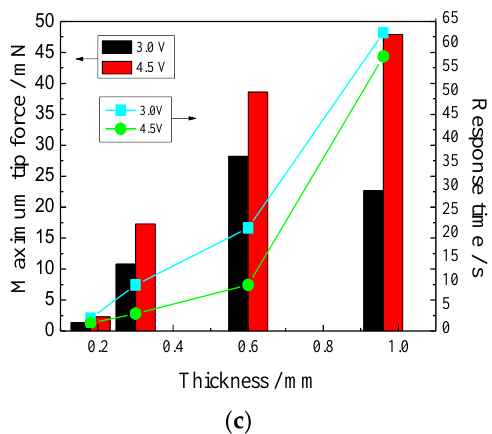
Figure 5. Tip forces of the IPMCs with various thicknesses under different voltages. ( a ) 3.0 V; ( b ) 4.5 V; ( c ) relationships between the maximum tip force or the response time and the thickness.